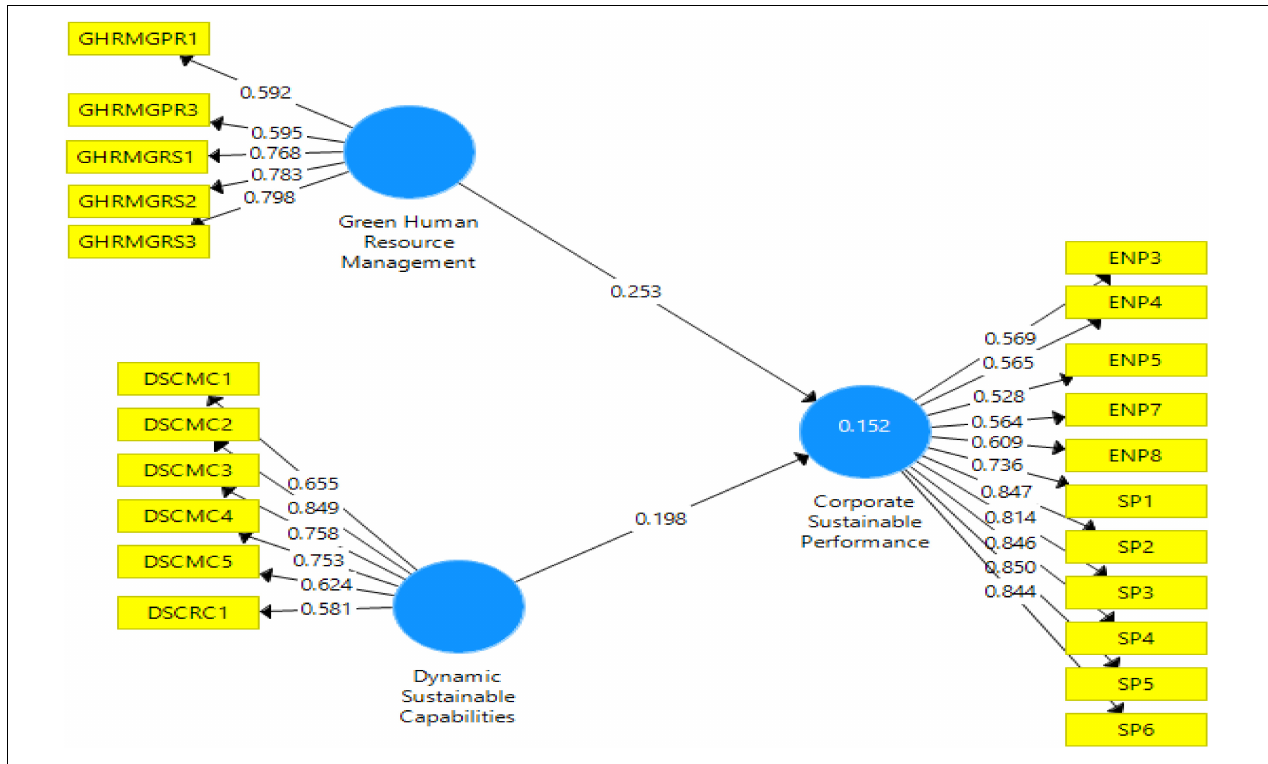
FIGURE 6 | Outer loadings of the main